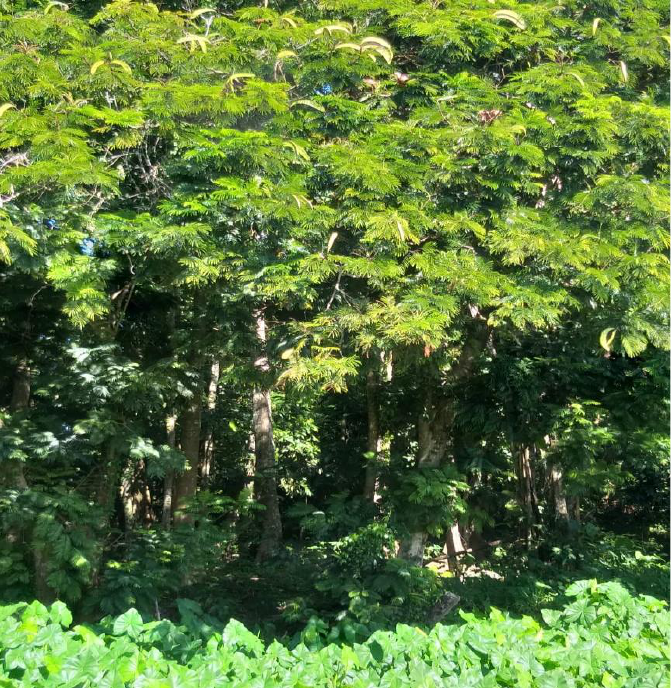
Figure 2 . Pracaxi tree in the northern region of Pará planted at the Federal University of Pará . Figure 2. Pracaxi tree in the northern region of Par á planted at the Federal University of Par á . Cruz and Barros [48] studied the biometry of pracaxi seeds and the results showed that the average mass was 5.42 g (approximately 100 seeds), the length was 42.2 mm, the width was 29.3 mm and the thickness was 8.3 mm. Soares et al. [59], when analyzing the anatomy of the fruits, seeds and seedlings of P. macroloba , described the fruits as being from 16 to 45.2 cm in length, from 4.1 to 7.3 cm in width, from 1.2 to 1.5 cm thick with 3 to 6 seeds